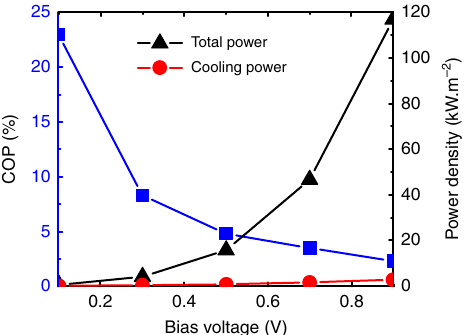
Fig. 4 Cooling power density. The cooling power density (red circles) and the input electrical power density applied to the heterostructures (black triangles) as a function of the bias voltage. The coef fi cient of performance (COP) is then obtained from the ratio of these two quantities (blue